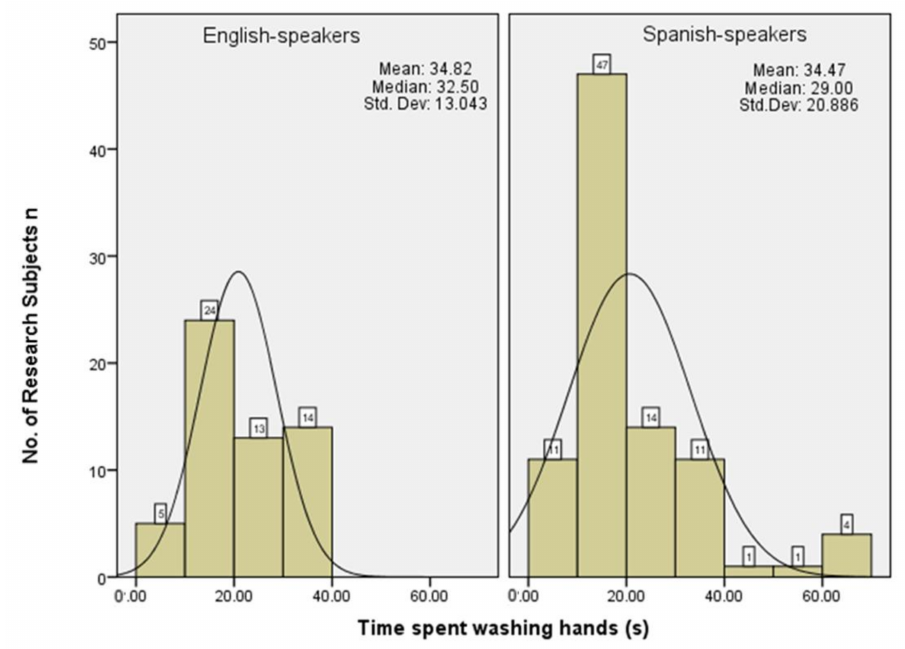
Figure 1. Self-reported handwashing times for UK and Spanish research subjects. In relation to hand drying (Figure 2), the mean length of time self-reported by UK research subjects was 25.16 s (SD: 12.74) and the range was between 6 and 52 s. The mean length of time self-reported by Spanish research subjects drying hands was 24.90 s (SD: 17.91) and the range was between 0 and 100 s. There was a statistically significant relationship between the time spent drying hands for both UK and Spanish research